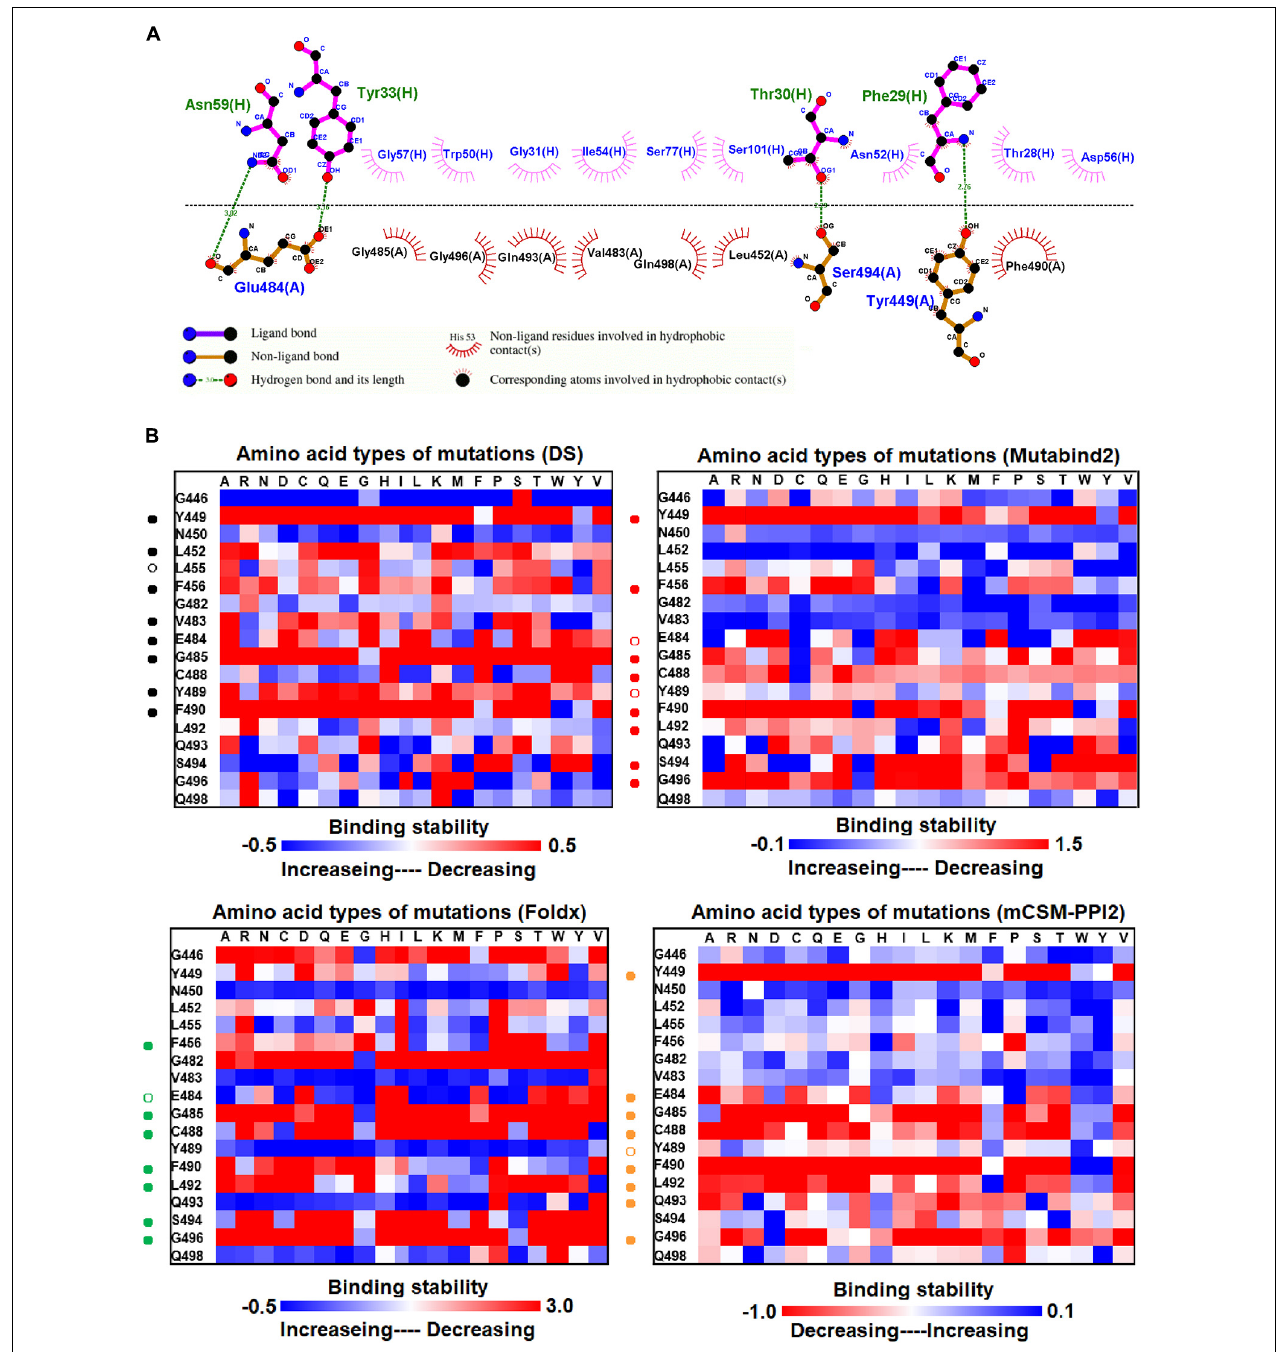
FIGURE 3 | The mutational binding stabilities of RBD variants interacting to VH1-2-15 nanobody. (A) The molecular interactions of SARS-CoV-2 RBD with VH1-2-15 nanobody analyzed by ligplot. The chains A and H correspond to RBD and VH1-2-15 nanobody, individually. (B) The heatmap of interactive residues of RBD derived from the calculated mutational binding stabilities by using Discovery Studio 3.5 (DS), Mutabind2, FoldX, and mCSM-PPI2. The boxes of each mutations were colored with the gradient of a range between blue (stabilized binding) and red (destabilized binding). In all panels, the solid and hollow circles indicate significant and moderate decreases of the binding stabilities,